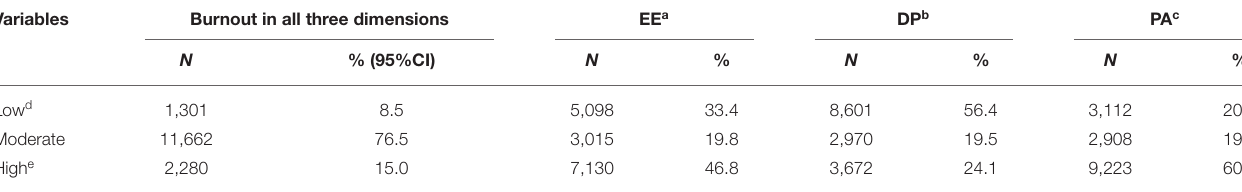
TABLE 2 | The prevalence of burnout in emergency physicians according to three distinct dimensions of